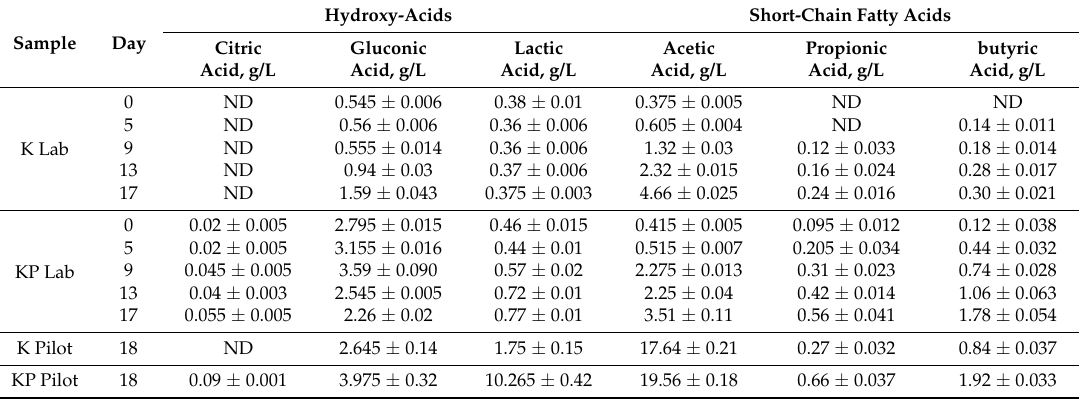
Table 2. Organic acids content during Kombucha fermentation with or w/o pollen addition.